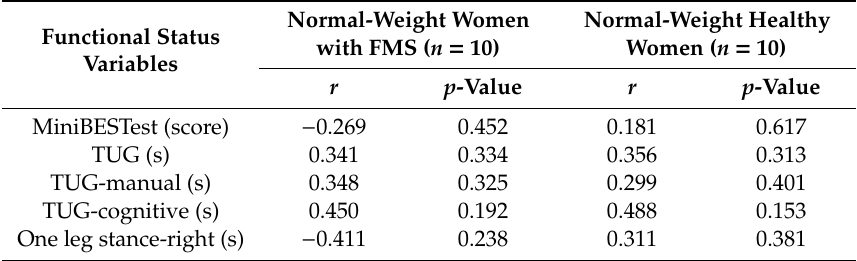
Figure 1. Levels of dynamic balance measured with the MiniBest and Timed up and go tests in women with fibromyalgia and healthy controls grouped by their body mass index (normal-weight versus overweight / obese). In the box plots, the boundary of the box closest to zero indicates the 25th percentile, the black line within the box marks the median, and the boundary of the box farthest from zero indicates the 75th percentile. Whiskers above and below the box indicate the 10th and 90th percentiles.